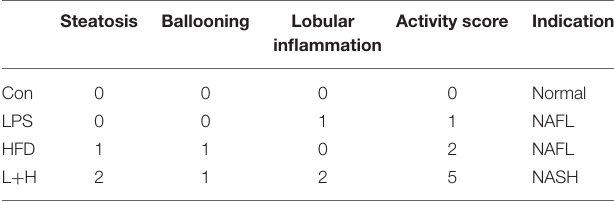
For each group, the mean score about each feature is given (n = 3).